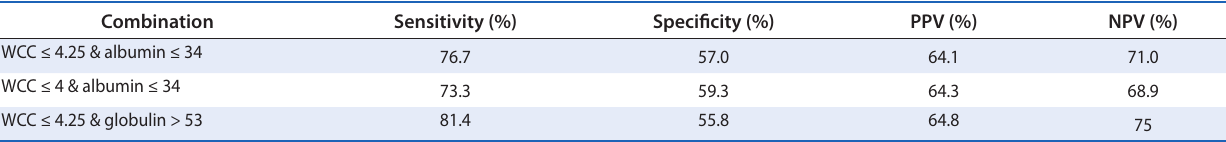
Table 3: Combination of markers at specific